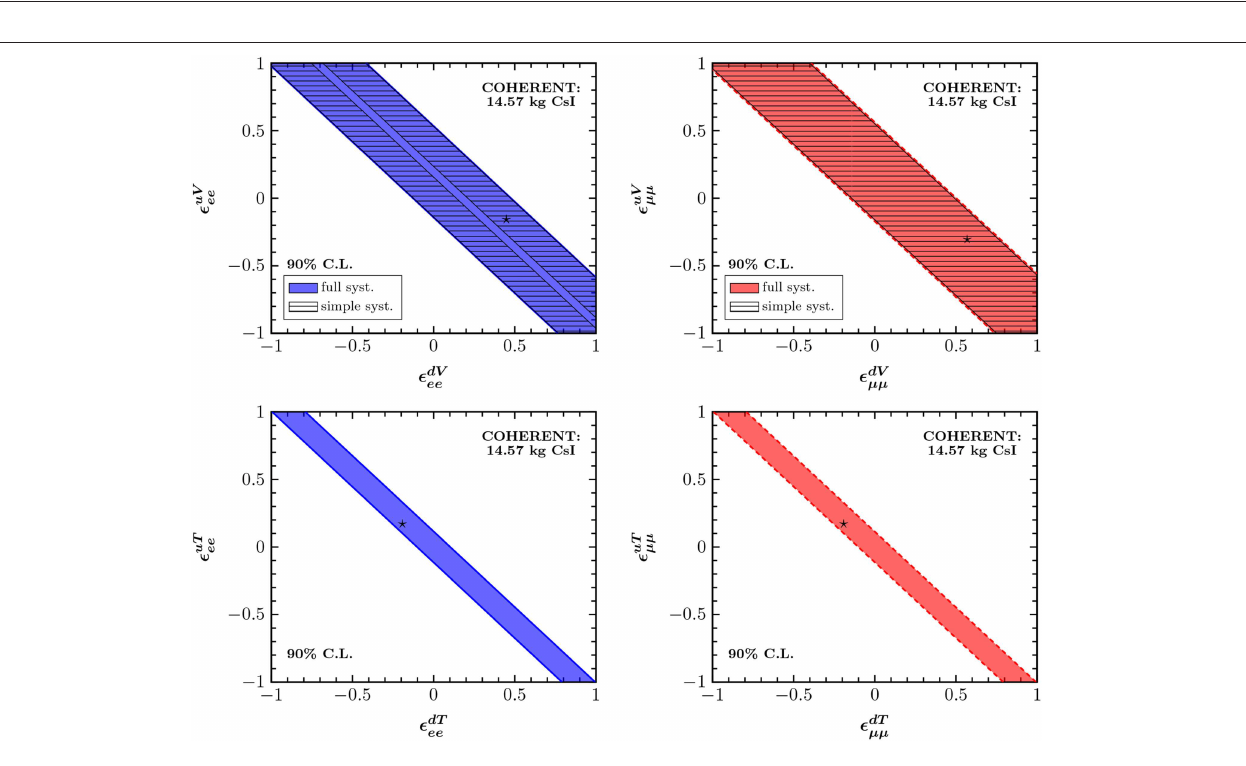
FIGURE 11 | Sensitivity contours in the vector (Upper panel) and tensor (Lower panel) NSI parameter space. The results are presented at 90% C.L. assuming ν µ ) beam, while the best-fit points are indicated by an asterisk ⋆ . Figure adapted from non-universal couplings only. The left (right) panel corresponds to the ν e ( ν µ + ¯ Papoulias and Kosmas [21] under the terms of the Creative Commons Attribution 4.0 International